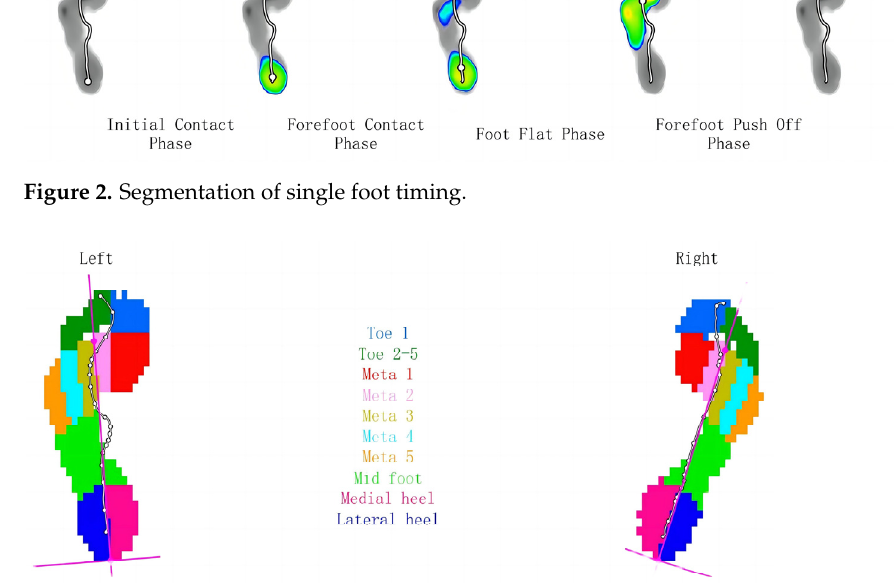
Figure 4. Foot axis angle. Observed indicators: Spatial-temporal gait parameters: (1) distance (m), duration (s), velocity (m/s), stance duration (s), and swing duration (s) in one gait cycle; (2) heel to heel base of support dis- tance of support middle foot (m), double support distance of support middle foot (m), single support distance of support middle foot (m); (3) single foot timing of about four phases for both feet. Foot axis parameters: foot axis angle, maximum subtalar joint angle, minimum sub- talar joint angle, and subtalar joint flexibility of both feet. (1) The foot axis angle is the angle between the foot axis direction and the walk direction, referring to the position of foot rotation related to the gait direction. A positive or negative value indicates external or internal rotation, respectively, of the foot in the horizontal plane [49]. (2) the minimum and maximum values, respectively, suggest the rearfoot’s maximal supination and maxi- mal pronation position. Force and pressure parameters: average Force (N), average pressure (Pa), peak force (N) and peak pressure (Pa) in 10 plantar pressure zones of both feet. Test requirements: Place the plate flat on the floor and connect it to the computer. To achieve a stable state of walking and reduce test errors, a person is required to carry out free walking three times before the formal test to familiarize themselves with the walking environment. All subjects should take off their shoes and socks and then step gradually from the front of the plate to the test plate. During the whole walking process, the person should keep their eyes straight ahead, walk naturally with a moderate pace, and swing their upper extrem- ities naturally. All subjects are required to walk over the plate 6–8 times. All measurements were performed following the order of body composition test, FMS, FMA, TUG, and foot plantar pressure test. The timing of the every test would be controlled within 5 min and the total duration of a whole test is no more than 30 min.